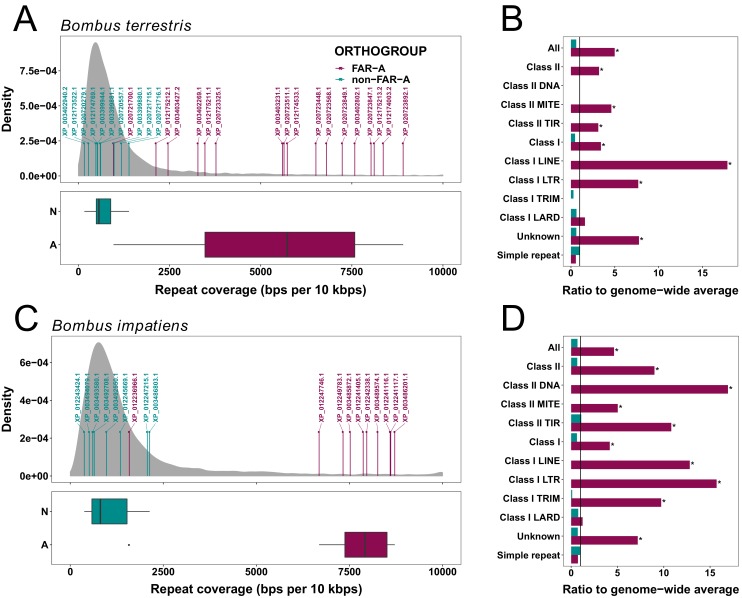
Average TE densities in 10 kb windows around groups of B. terrestris (A, B) and B. impatiens (C, D) genes.(A and C) Distributions of overall TE densities around FAR genes (N, non-FAR-A genes, in green; A, FAR-A genes, in red) with respect to the genome-wide distribution of TE densities around RefSeq genes (in grey) are shown for the B. terrestris (A) and B. impatiens (C) genomes. (B and D) Densities of individual TE classes and families for FAR-A (in red) and non-FAR-A (in green) genes are depicted for B. terrestris (B) and B. impatiens (D). The average TE densities for the whole gene group are compared to the genome-wide average. Asterisks indicate statistical significance obtained by permutation test.10.7554/eLife.39231.012Figure 3—source data 1.List of TE densities for FAR-A and non-FAR-A genes.